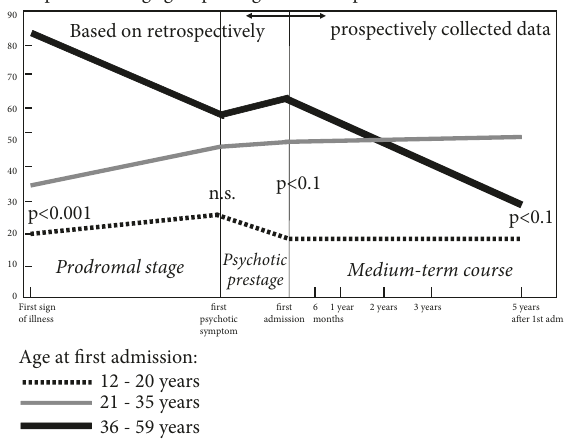
Figure 8: Social course of schizophrenia as based on economic independence (smoothened curves) in the early and medium-term illness coursein threegroups of patientsaged 12-20,21-35, and 36-59 yearsatinclusioninstudy(=firstadmission),ABCfollow-upsample (n=115). Source: [60],